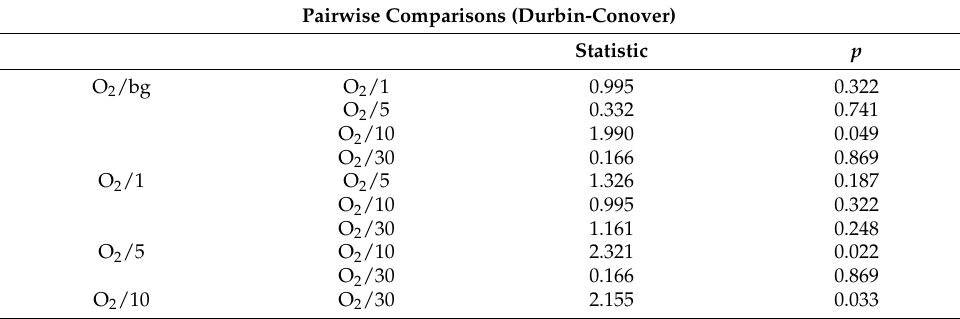
Table 5. Within-the-group comparison of oxygen content at different time